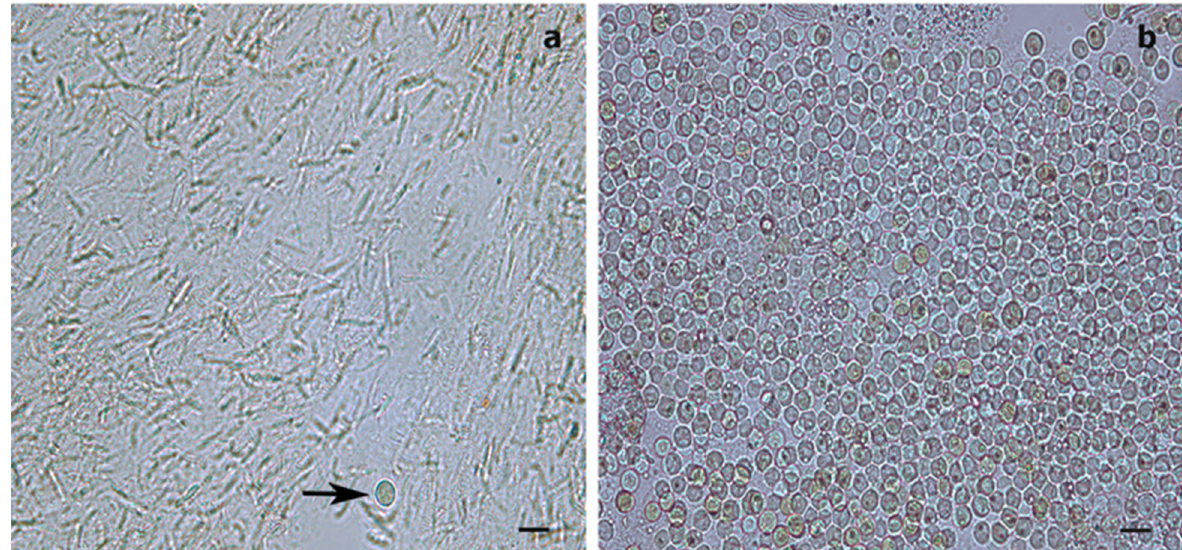
Figure 3. Light microscopy images of Symbiodiniaceae-like extracts obtained through the sodium hydroxide isolation method. ( a ) Extract from the antipatharian Cupressopathes abies showing only one Symbiodiniaceae-like cell (arrow) but abundant cnidocytes. ( b ) Extract from the scleractinian Seriatopora hystrix showing numerous Symbiodiniaceae-like cells, corroborating the efficiency of the isolation method. Scale bars = 10 μ m.